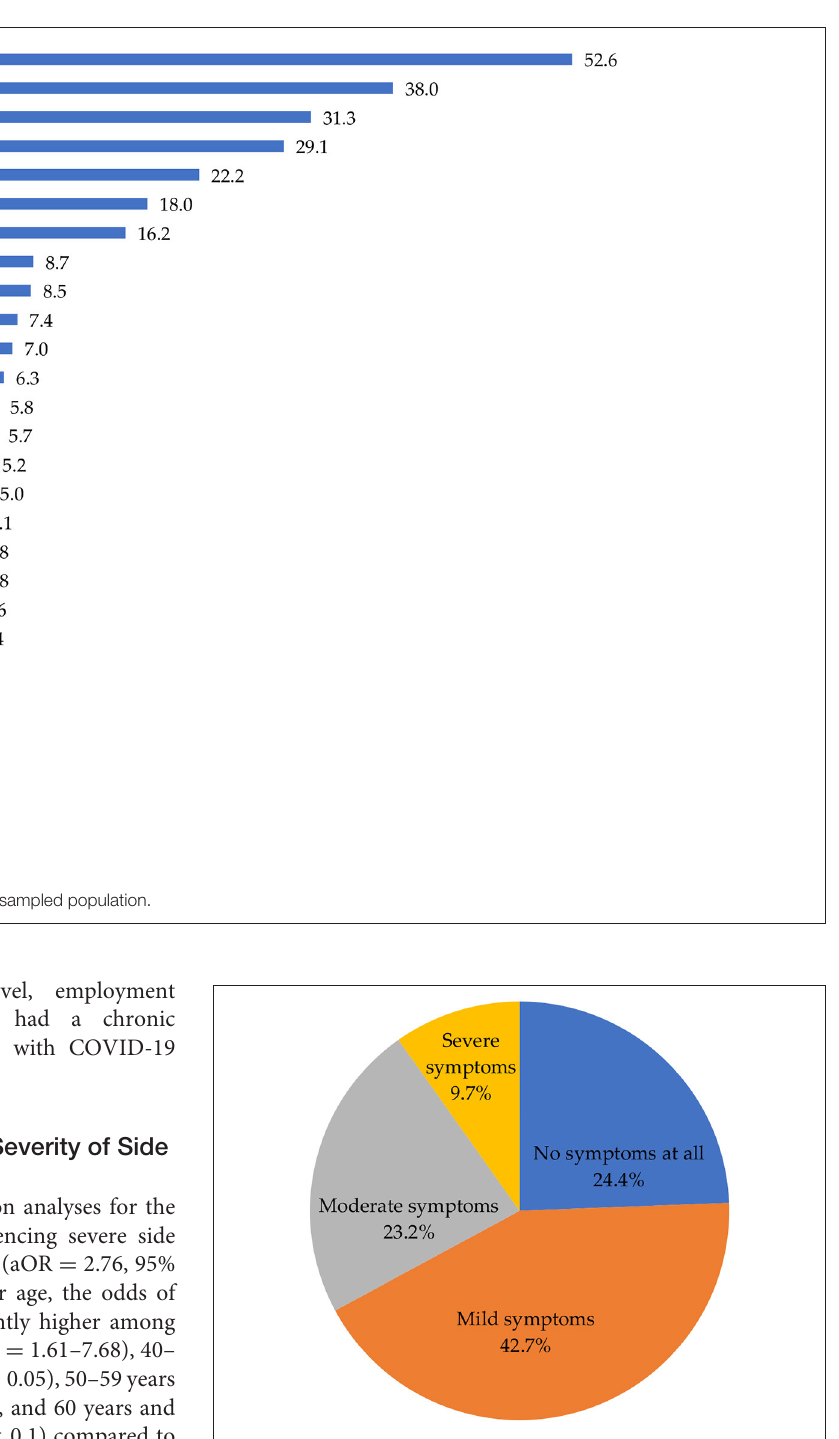
FIGURE 4 | Severity of side effects after